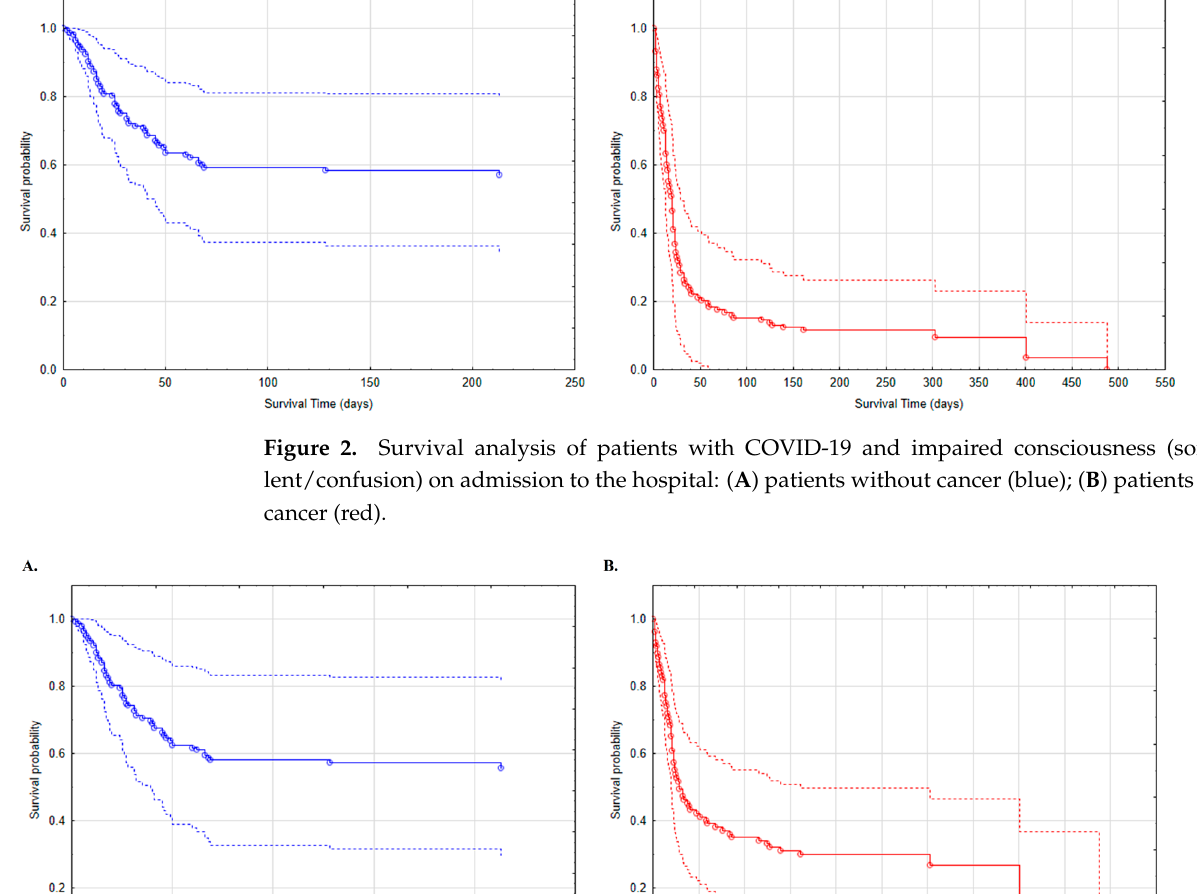
Figure 1. Survival analysis of patients with COVID-19: without cancer (blue); with cancer but with- out metastases (yellow); with cancer with metastases (red). ( A ) women; ( B ) men.